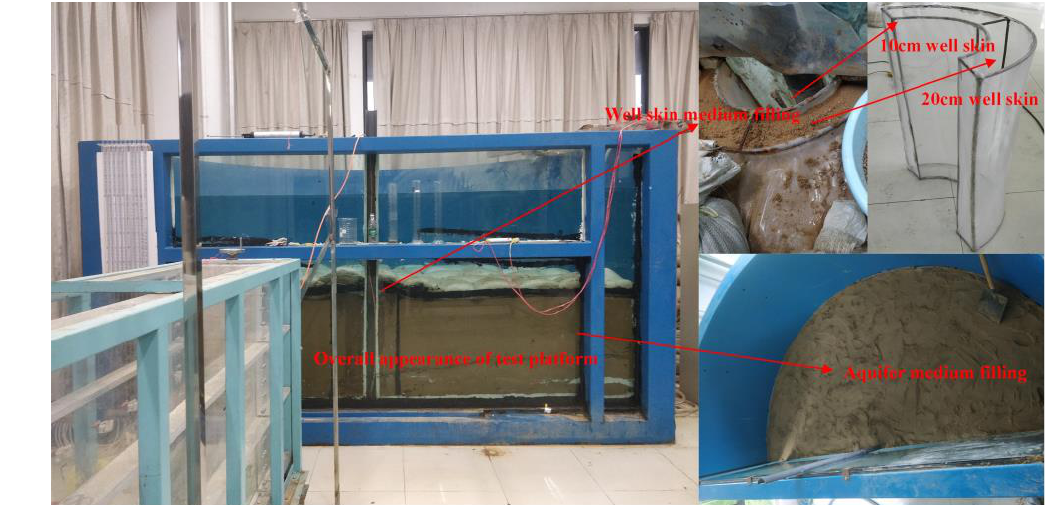
Figure 5. Physical picture of indoor test platform.